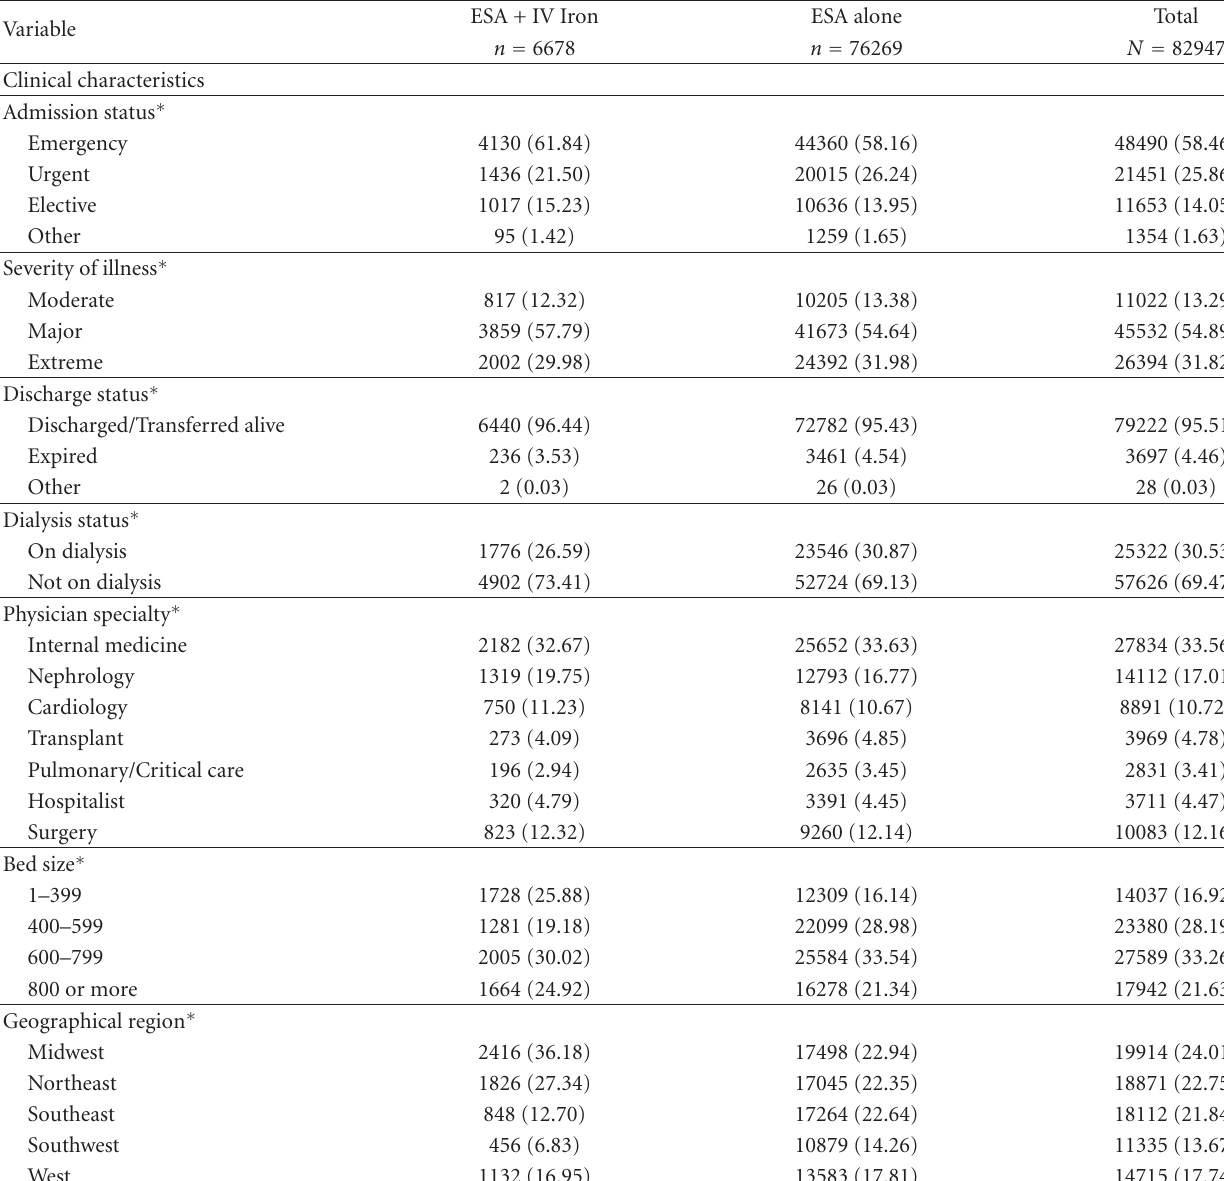
Table 4: Clinical characteristics of the study sample.